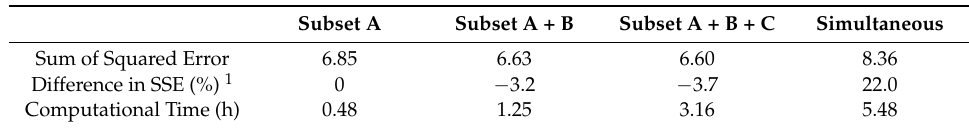
Table 2. Comparison Sum of Squared Error of obtained models by sequentially and simultaneously re-estimating model parameters.